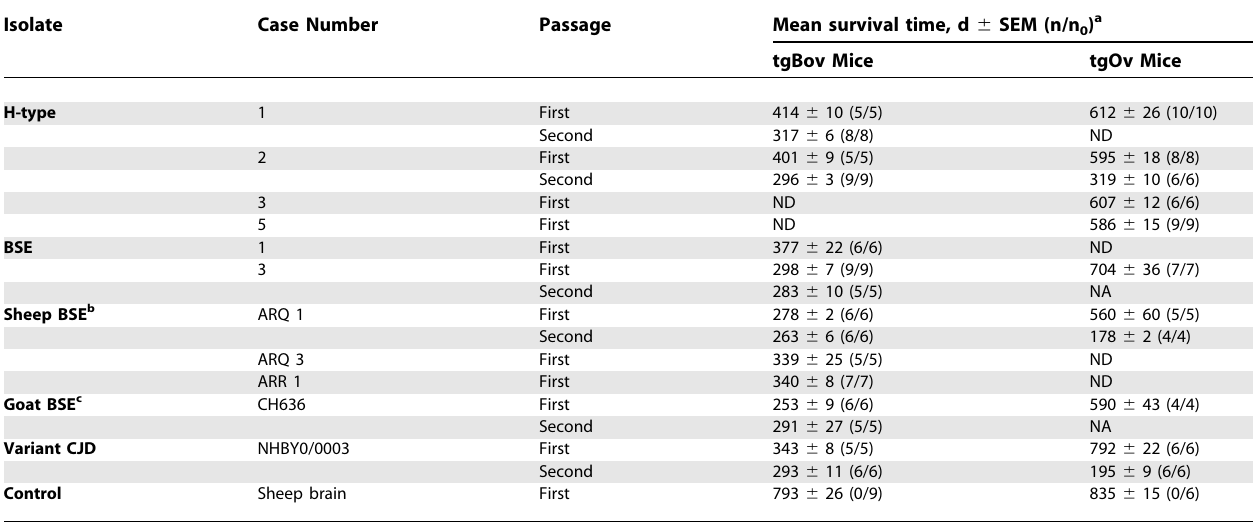
Table 1. Transmission of Bovine Molecular Variant Cases (H-Type) to Transgenic Mice Expressing Bovine or Ovine PrP